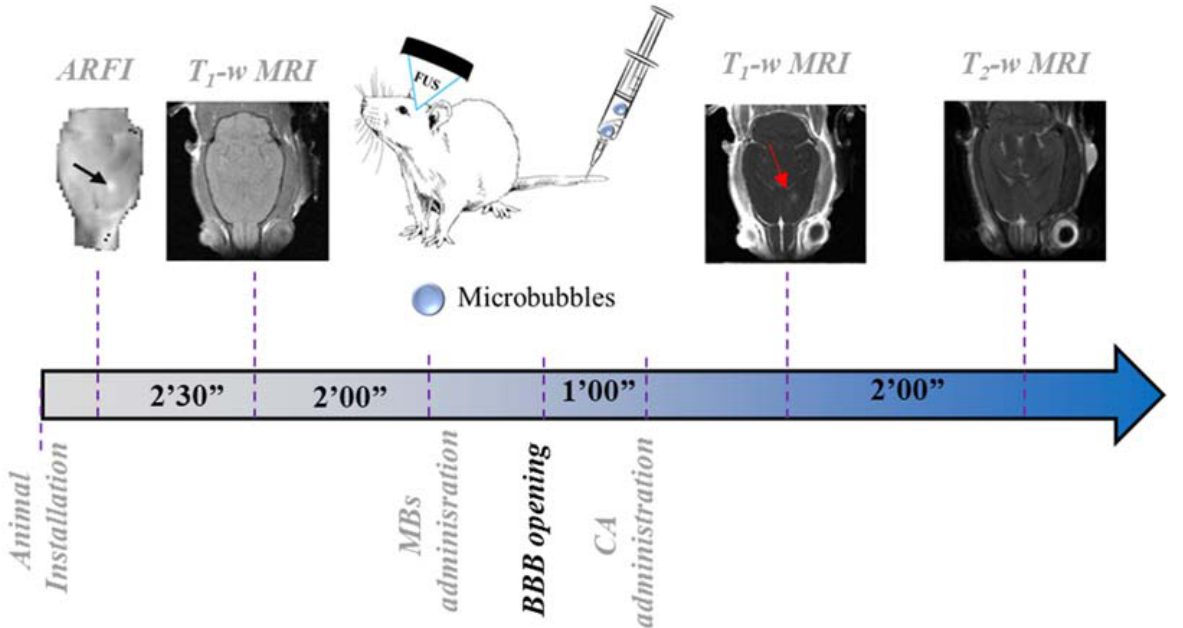
Figure 4. Experimental protocol for in vivo experiments and timelines for the BBB permeabilization procedure and MRI acquisition. After the installation of the animal in the MRI scanner, the position of the FUS focal spot was confirmed with an MR-ARFI sequence. This acquisition was then followed by a T 1 -w scan acquired before BBB opening. One minute after FUS application and MRI-CA administration, T1-w (2 min acquisition) and T2-w (2 min) images were acquired to evaluate the extension of the BBB disruption and the presence of damages, respectively.